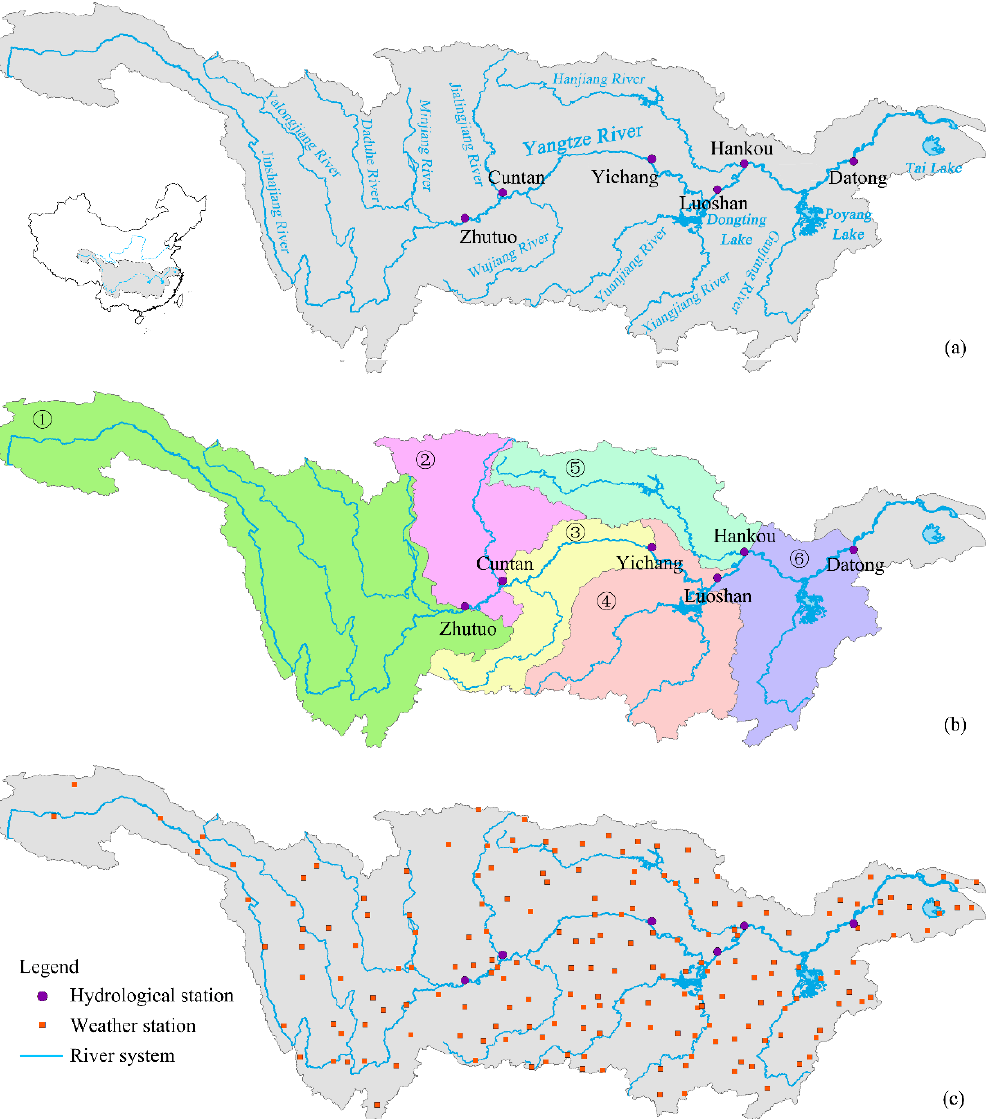
Figure 1. Sketch map of the location of the Yangtze River Basin. ( a ) Locations of relevant hydrological stations; ( b ) Locations of river systems and sub-regions; ( c ) Locations of weather stations. Note: ① , ② ,…, ⑥ represent the catchment area of each hydrological station along the mainstream.